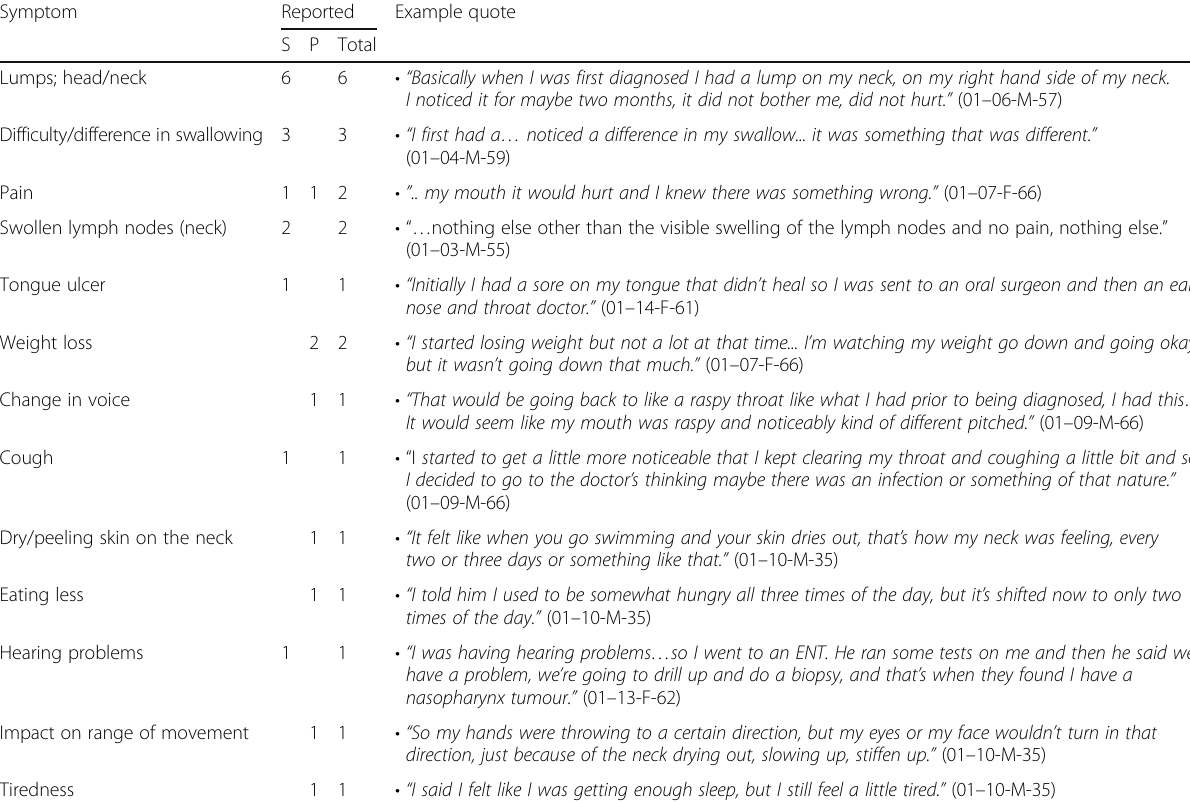
Table 3 Overview of signs and symptoms experienced by patients prior to treatment Symptom Reported Example quote S P